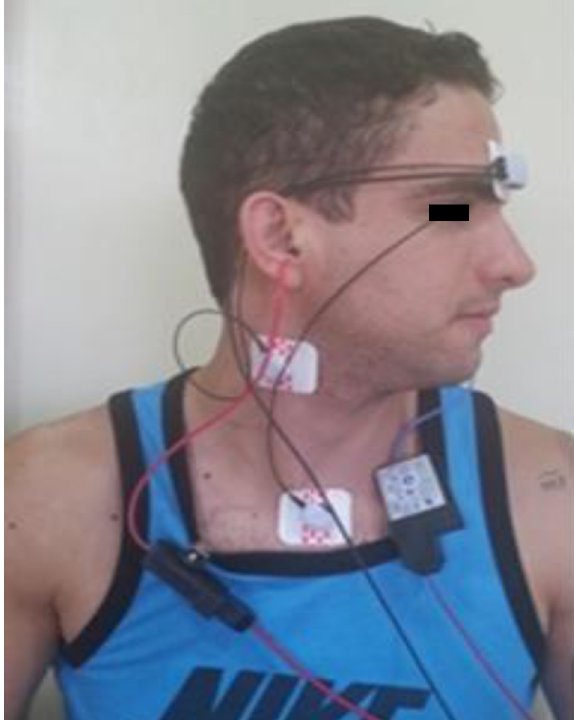
Figure 1 VEMP performed on the right. The presence of reproducible waves and